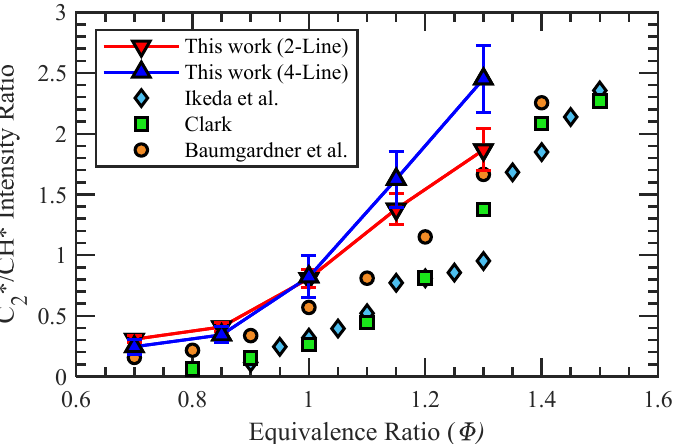
Figure 7. Four ‐ line and two ‐ line calibrations of C 2 */CH* intensity ratio to Φ for propane–air mixtures. Figure 7. Four-line and two-line calibrations of C2*/CH* intensity ratio to Φ for propane–air